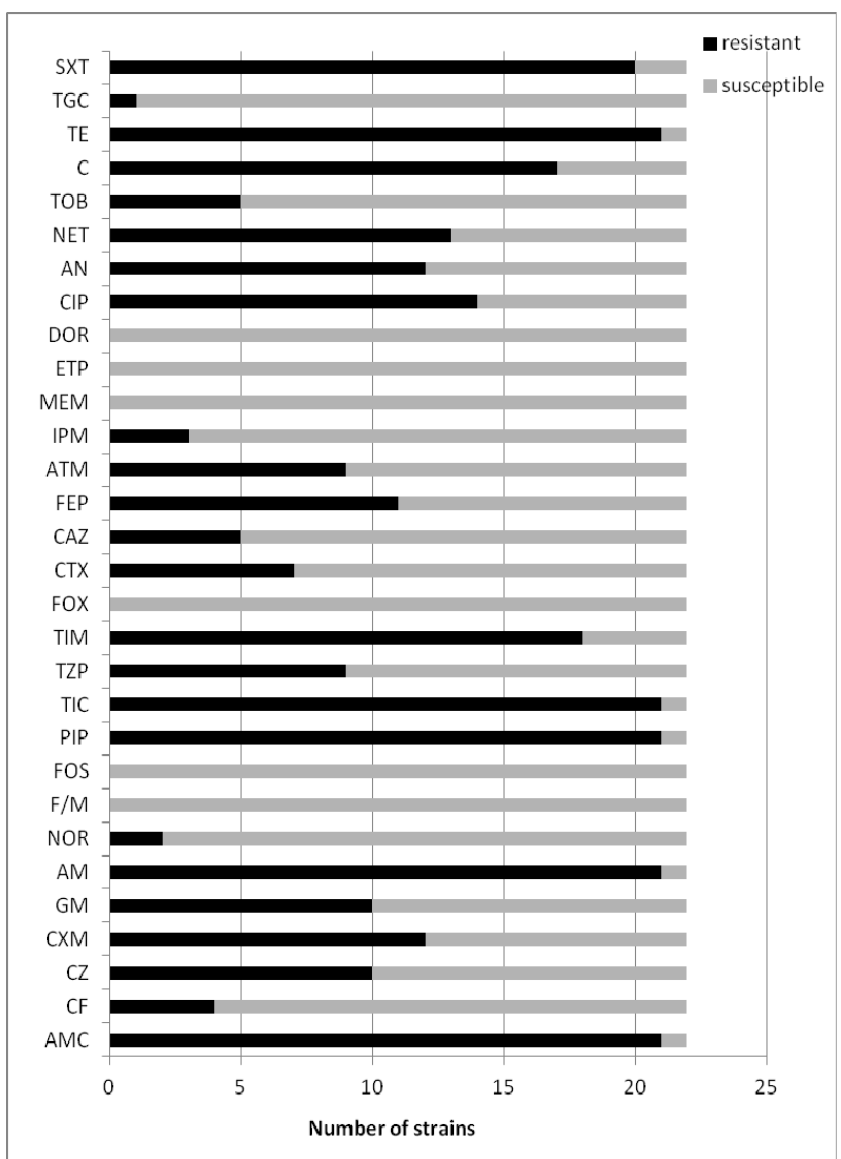
Figure 1. The susceptibility testing of clinical Escherichia coli (ESBL+)